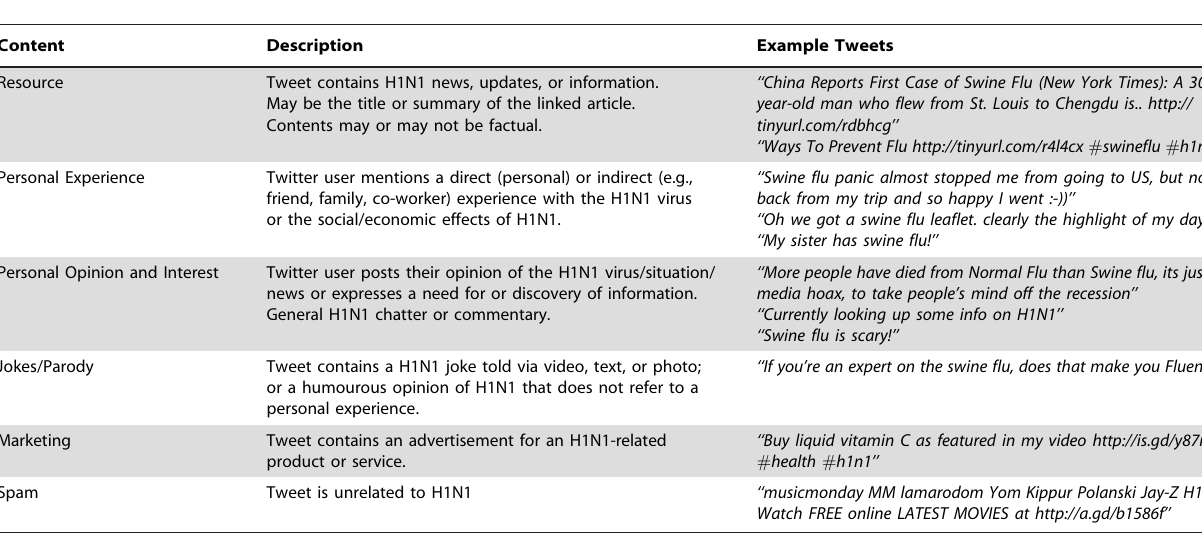
Table 1. Descriptions and Examples of Content Categories.